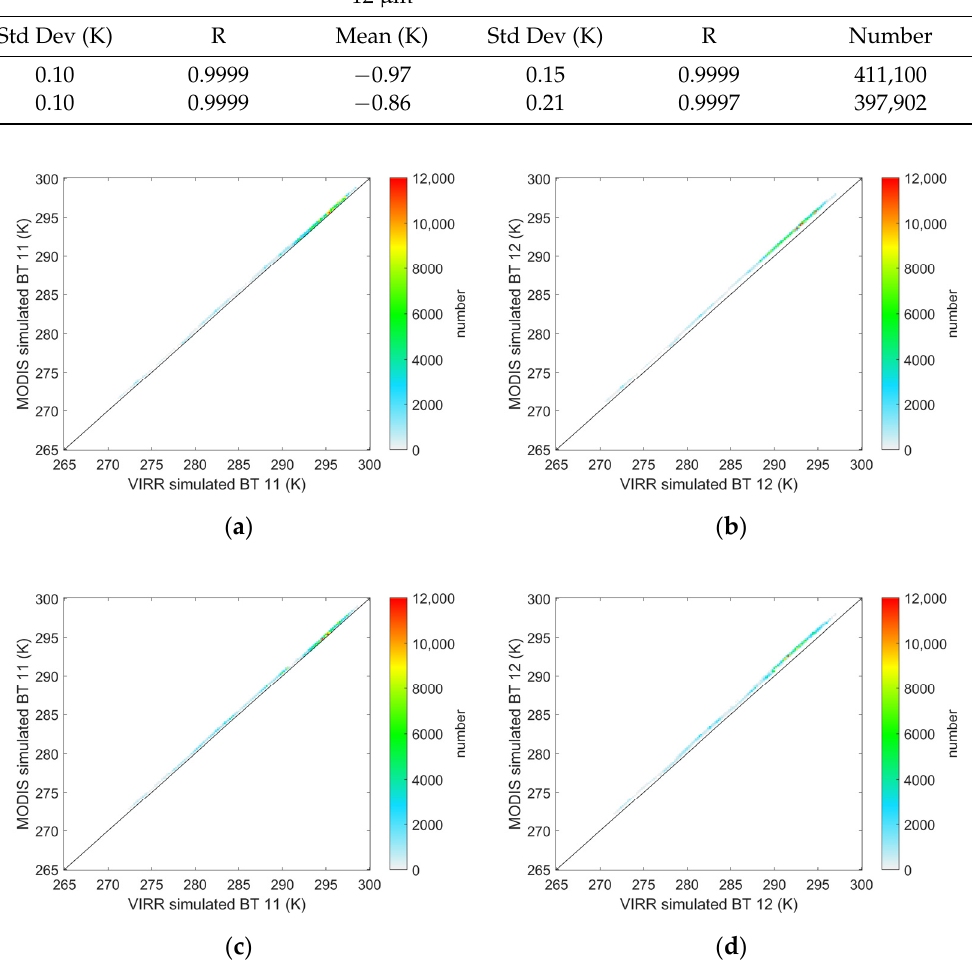
Figure 3. The relationship between VIRR and MODIS simulated BT: ( a ) 11 µ m in the daytime; ( b ) 12 µ m in the daytime; ( c ) 11 µ m in the nighttime; ( d ) 12 µ m in the nighttime. Table 3. The Double Difference between VIRR_BT and MODIS_BT (D means daytime, N means nighttime, R means correlation coefficient).